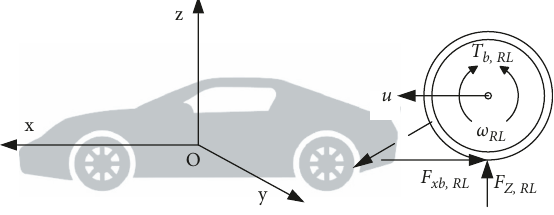
Figure 2: Vehicle braking dynamics